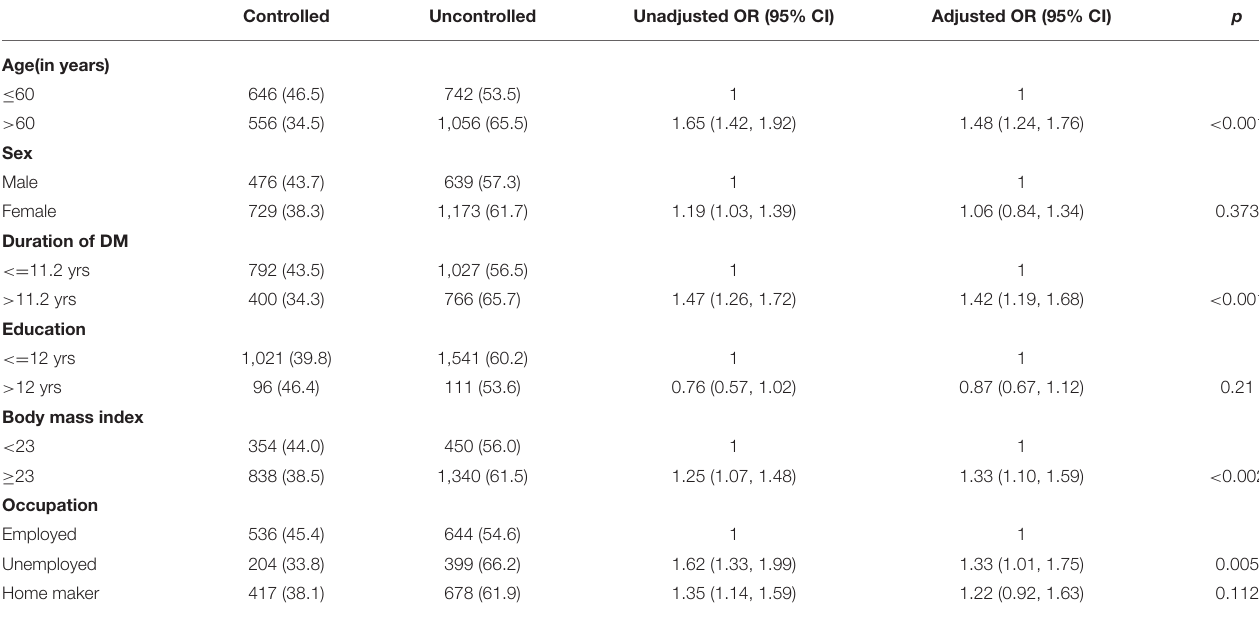
TABLE 2 | Factors associated with uncontrolled blood pressure adjusted for clustering. Controlled Uncontrolled Unadjusted OR (95% CI) Adjusted OR (95% CI)